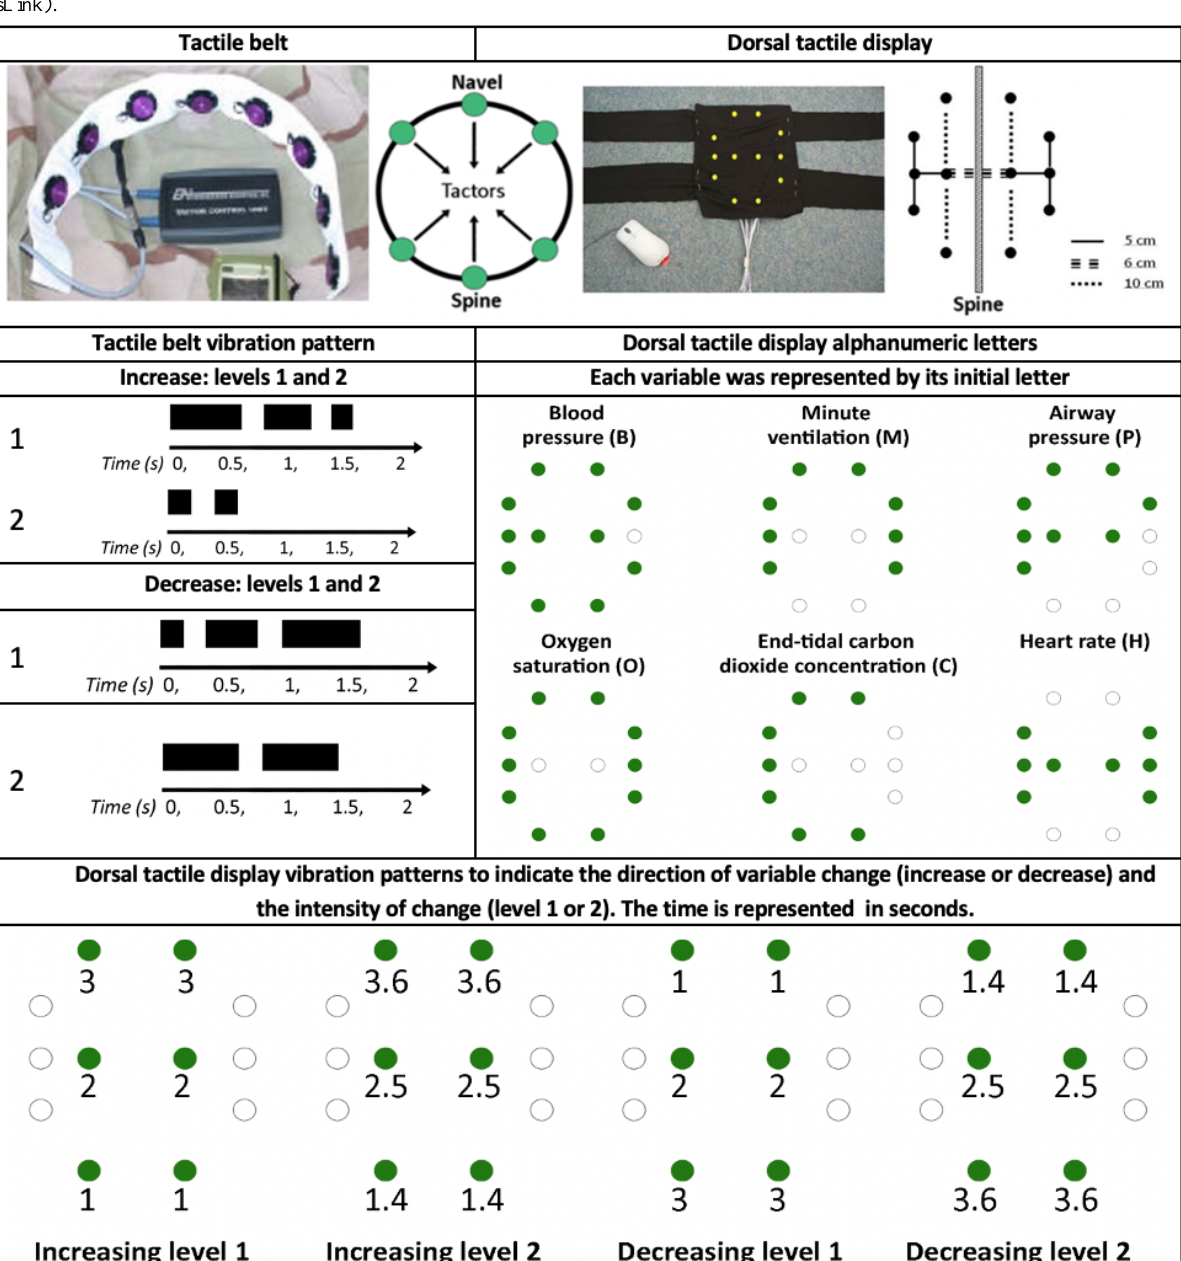
Figure 9. Tactile displays by Barralon et al [21]. Tactile belt worn around waist and dorsal tactile display positioned along the back. The tactile belt was designed to monitor 6 variables, each represented by a tactor with 4 possible vibration patterns. For the dorsal tactile display, each variable was represented by the tactors forming its initial letter. For each letter, the sequential locations were activated for 300 milliseconds, followed by a 700-milliseconds pause and a sequence of vibrations to indicate the level and direction of change (permission to use the image obtained through